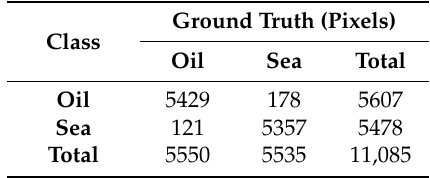
Table 4. Confusion matrix achieved by SVM based on 8 fully polarimetric features.